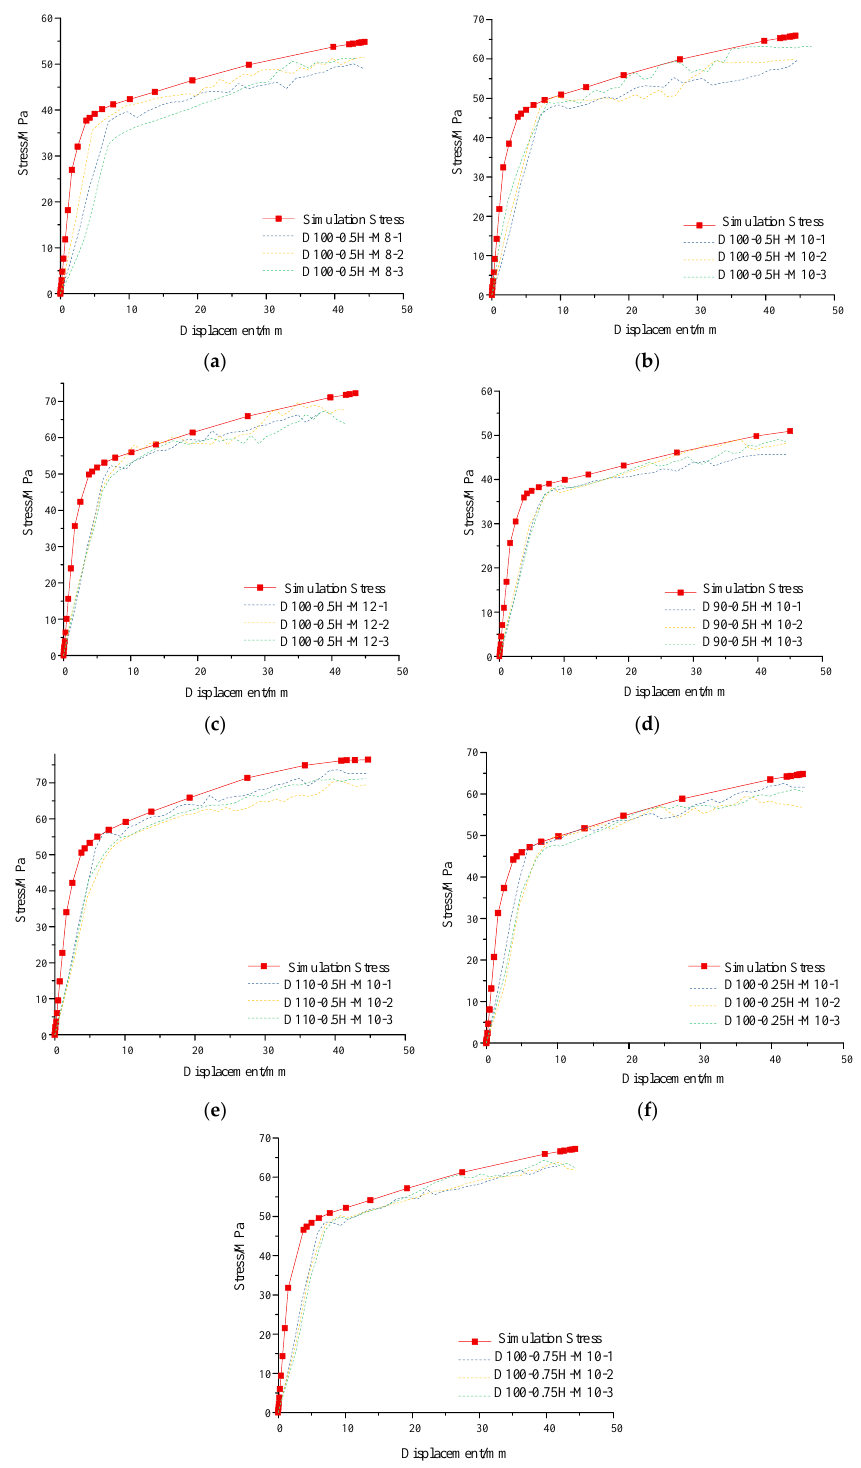
Figure 10. Comparison of simulated and test stress – displacement curves of composite joints. ( a ) Stress – displacement curves of D100-0.5H-M8; ( b ) Stress – displacement curves of D100-0.5H-M10; ( c ) Stress – displacement curves of D100-0.5H-M12; ( d ) Stress – displacement curves of D90-0.5H-M10; ( e ) Stress – displacement curves of D110-0.5H-M10; ( f ) Stress – displacement curves of D100-0.25H- M10; ( g ) Stress – displacement curves of D100-0.75H-M10.